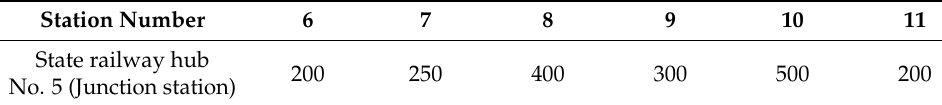
Table 4. State railway passenger demand in one operation